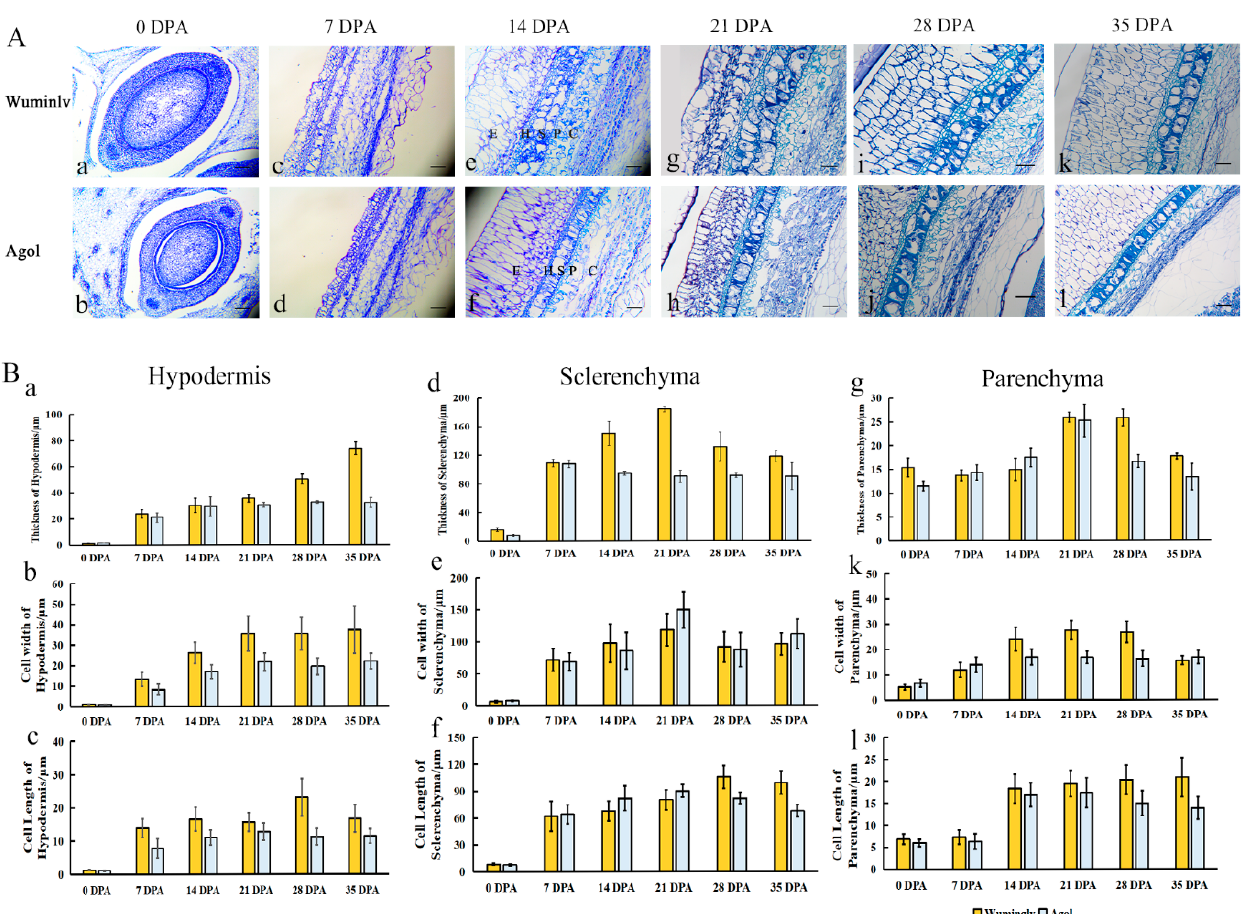
Figure 2. Histochemical analysis of the seed coat at different stage of seed development. ( A ) Morphological structures of seed coat. Dynamic changes of seed coat in Wuminglv and Agol at 0 (a, b), 7 (c, d), 14 (e, f), 21(g, h), 28 (i, j), 35 (k, l) DPA. Different characters represented cell layers as Epidermis (E), Hypodermis (H), Sclerenchyma (S), Parenchyma (P), and Chlorenchyma (C). Bar = 100 μ m. ( B ) The statistics analysis of cell layers of hypodermis (a, b, c), sclerenchyma (d, e, f), and parenchyma (g, h, l).